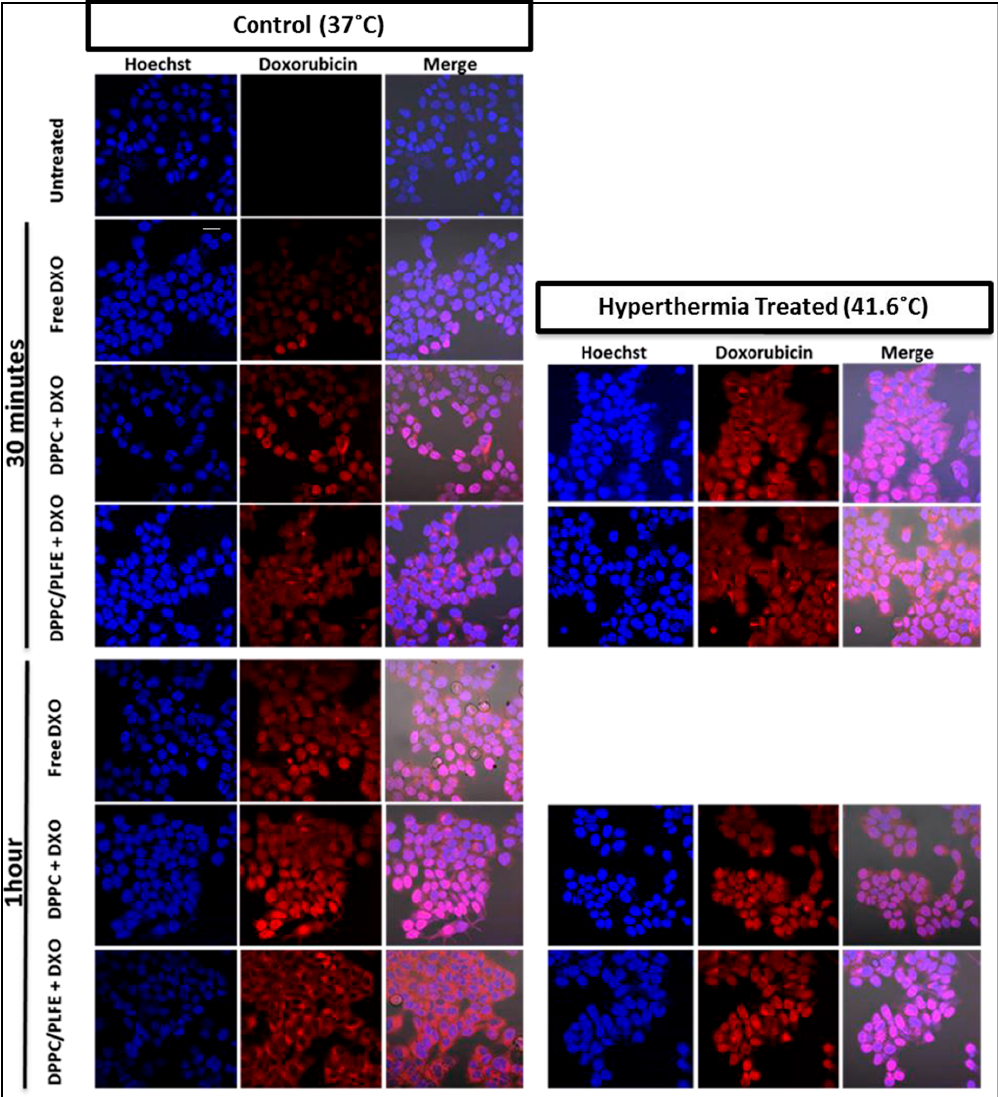
Figure 6. Confocal images of MCF-7 cells treated with free DXO and liposomal DXO with and without hyperthermia treatment. MCF-7 cells treated with 30 nmol of free DXO, DPPC liposomal DXO, or hybrid archaeosomal DXO containing 30 mol% PLFE/70 mol% DPPC for 30 min or 1 h at 37 ° C, after a 15 min pre-incubation at 37°C (control) or 41.6°C (hyperthermia treatment) (see Figure S4 for the experimental setup). Scale bar = 20 µm.